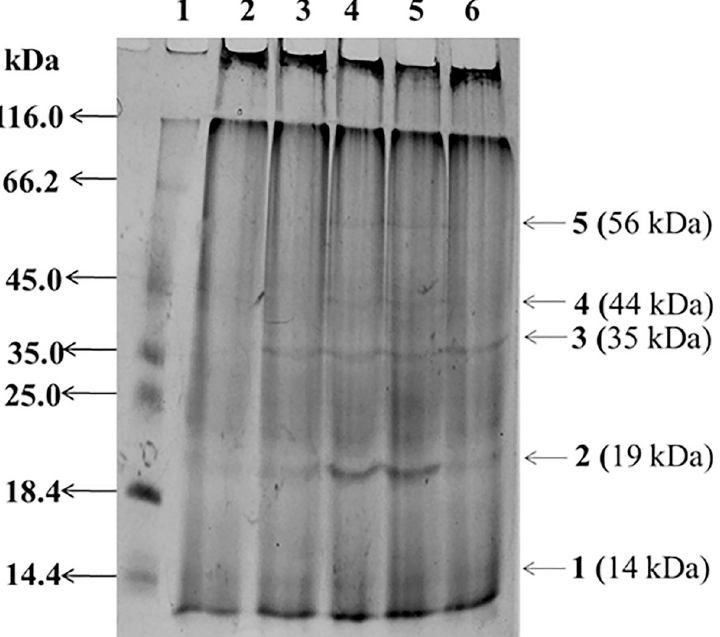
Fig 8. Protein profiling by SDS-PAGE showing the SA-induced changes in mycelial proteins of P . microspora analyzed. Lane 1: Marker; Lane 2: M-1D medium; Lane 3–6: 150, 250, 300 and 1200 μ M, respectively of SA induced